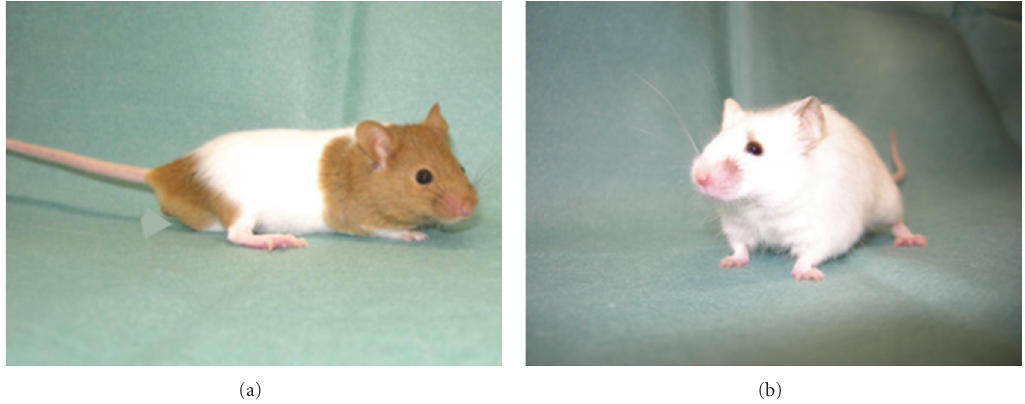
Figure 3: Microscopic features of skins obtained from NC/NgaTnd mice raised in SPF (a) or conventional (b) circumstances.